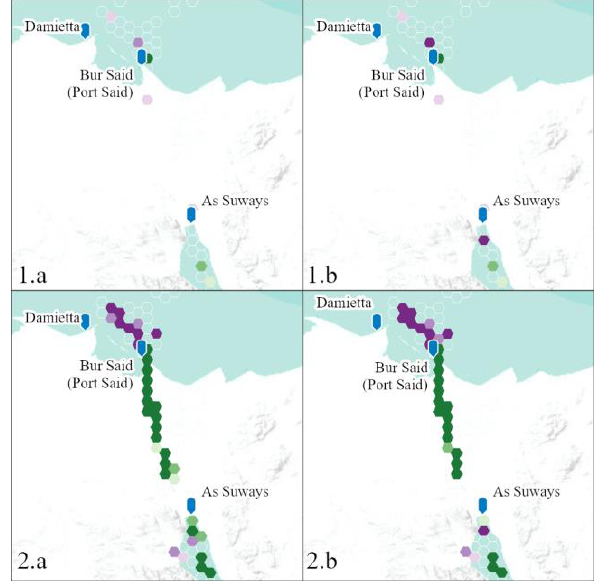
Figure 17 Trend analysis on counted AIS’ positions (a) and means TEUs over all bin locations, for the Suez Canal chokepoint, and directed to European and Mediterranean ports (1) or to Asian ports (2). (Basemap sources: Esri, USGS,